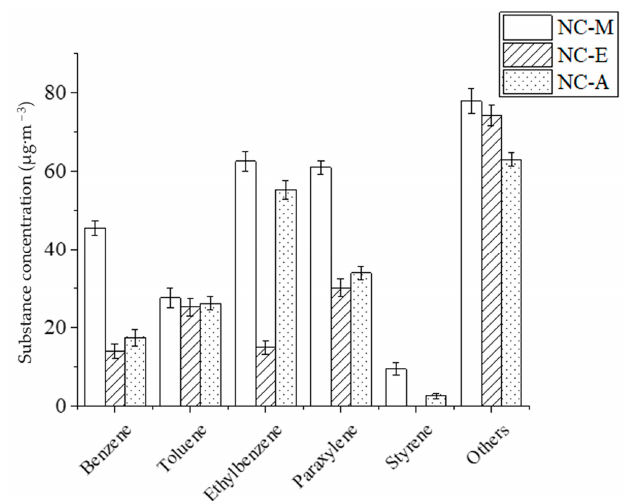
Figure 1. Concentration of Benzene Series released by MDF coated by the three NC paints.